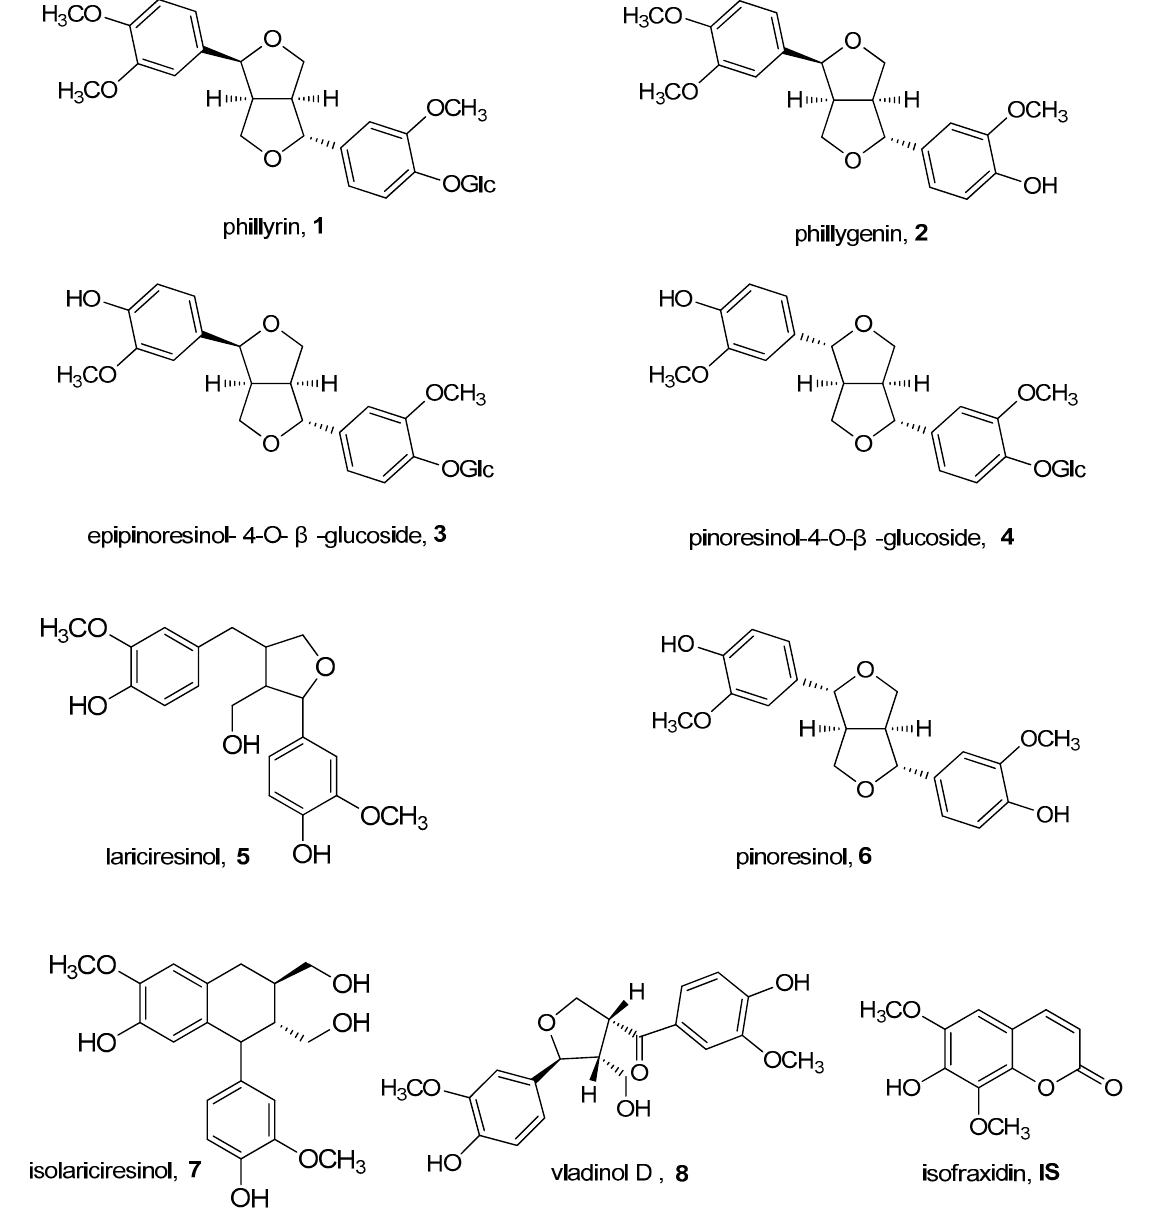
Figure 1. Chemical structures of lignans 1 – 8 and internal standard (IS).